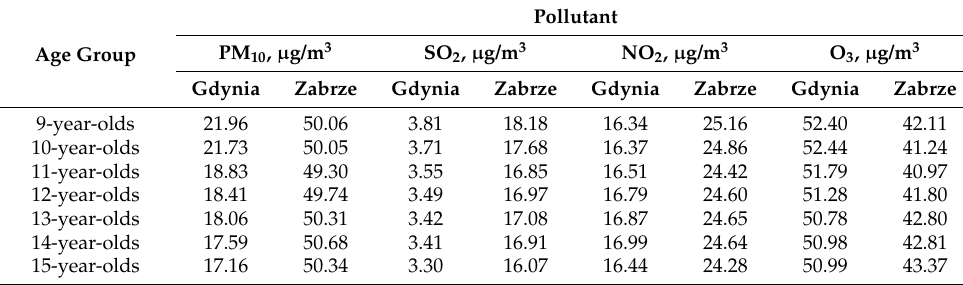
Table 1. Air pollution in Gdynia and Zabrze—whole-life exposure by age group.